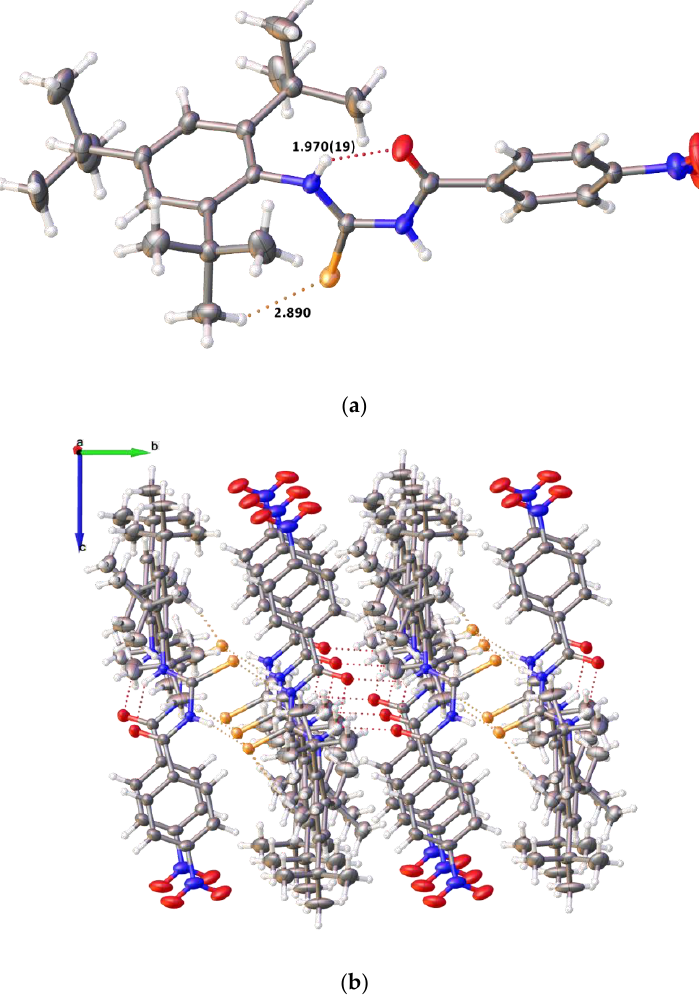
Figure 2. ( a ): intramolecular interactions seen in 2 ; ( b ): supramolecular structure in 2 . Atoms colors are the same as in Figure 1 except hydrogen, which is white.